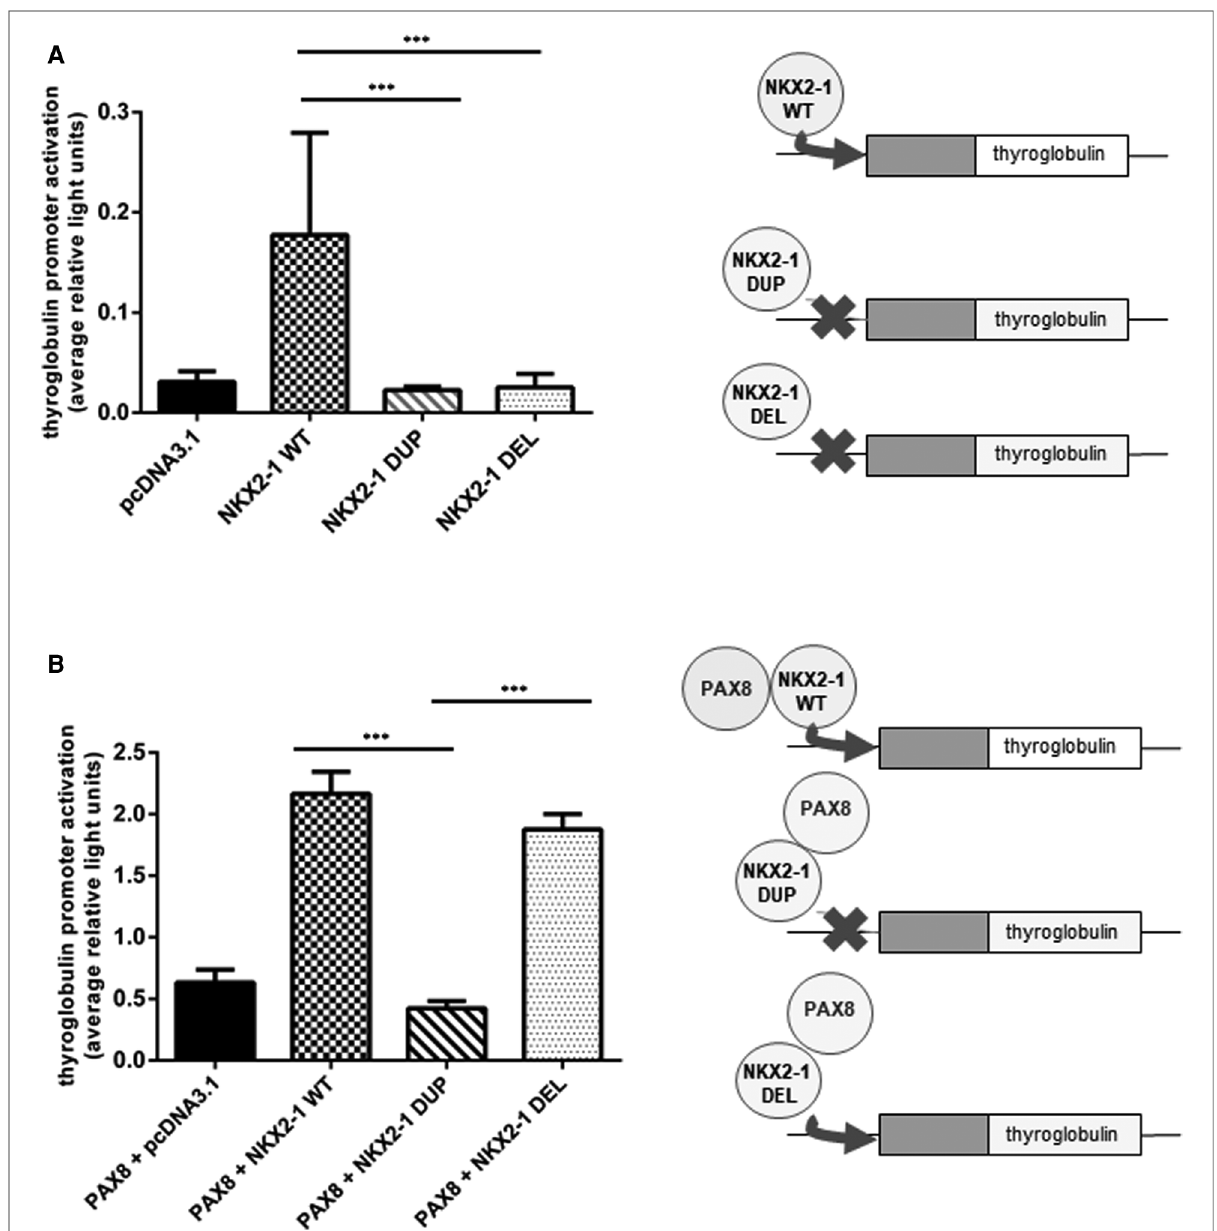
FIGURE 4 Functional activity of wild-type vs. mutants NKX2-1 on thyroid-speci fi c (thyroglobulin) gene. Transactivation of the thyroglobulin promoter by NKX2- 1 WT , NKX2-1 DUP or NKX2-1 DEL . Promoter constructs were co-transfected without ( A ) or with ( B ) PAX8 in Nthy cells with the empty pcDNA3.1 vector or the expression vector for wild-type or mutated NKX2-1 cDNAs. Data are mean±SEM of fi ve independent experiments performed in duplicate. *** p <